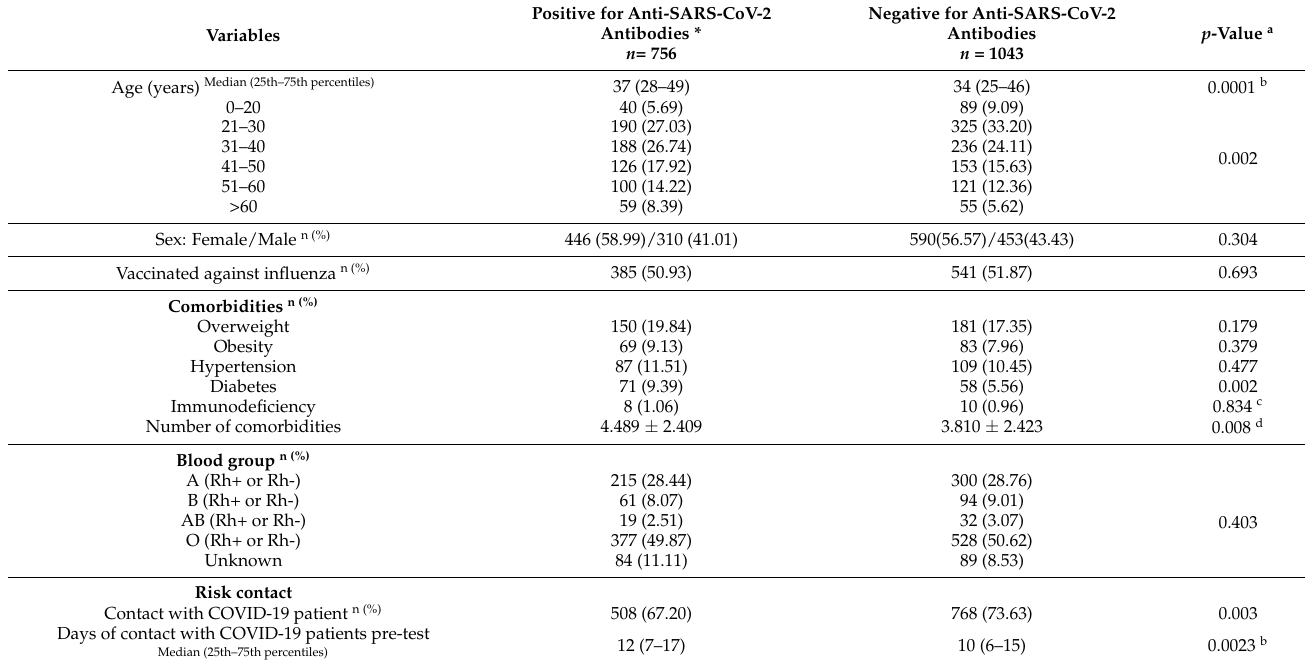
Table 1. Demographic characteristics, comorbidities, and risk contacts of individuals negative or positive to anti-SARS-CoV-2